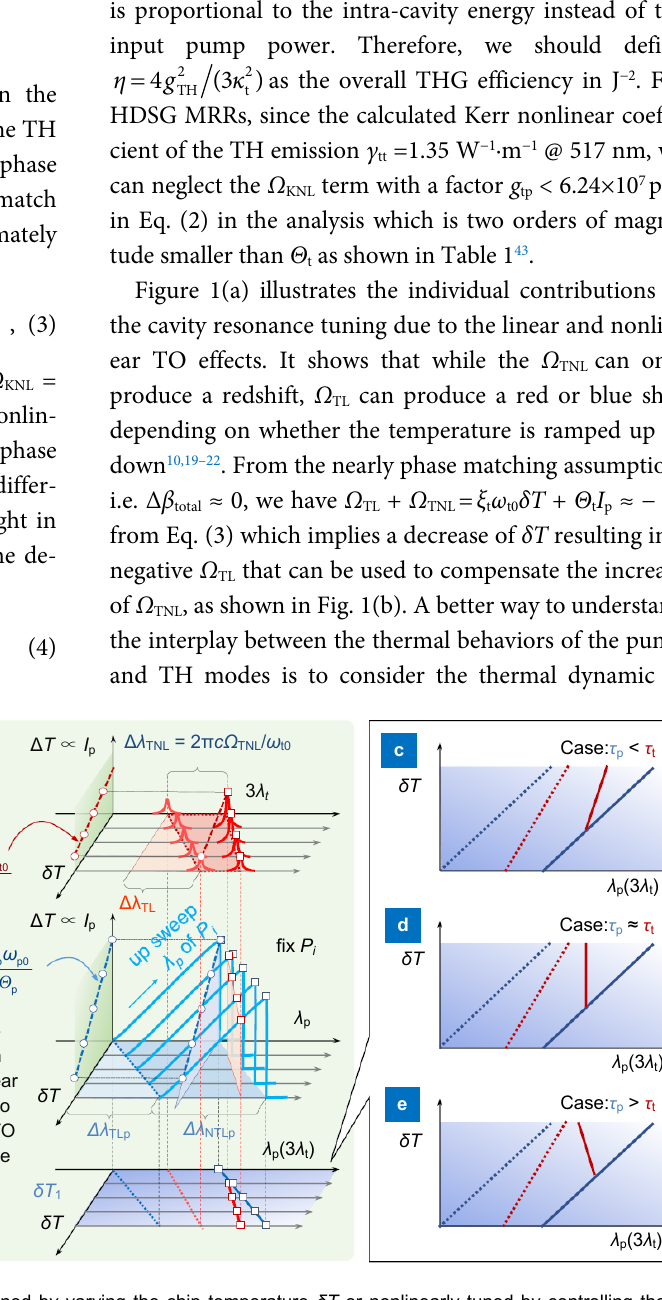
Fig. 1 | ( a ) The cavity resonance of MRRs can be linearly tuned by varying the chip temperature δ T or nonlinearly tuned by controlling the in- tra-cavity pump energy I p through nonlinear TO effects. ( b ) In the wavelength domain, when δ T increases, the cold-cavity resonance wavelengths of the TH mode (in red dot line) and the pump mode (in blue dot line) will linearly redshift ∆ λ TL and ∆ λ TLp , respectively. When up sweeping the CW input pump wavelength λ p and δ T are fixed, the corresponding I p will induce nonlinear redshift ∆ λ TNL and ∆ λ TNLp to the resonance wavelengths of the TH and pump modes, respectively. For the pump mode, when λ p is fixed, the trace of blue open circles determines τ p which is the ratio between δ T and I p . Similarly, the trace of red open circles in the upper part of (b) gives the ratio τ p . The overall effects of ∆ λ TL and ∆ λ TNL determine the effective TDWS of the TH mode which becomes a δ T- λ p relationship by mapping the trace of red open squares to the lower part of (b). For the pump mode, its TDWS is only related the linear TO redshift ∆ λ TLp whose trace was shown as blue open squares plotted in the δ T- λ p diagram. ( c – e ) The thermal mismatch between τ p and τ t will determine the effective TDWS of the TH mode, which leads to (c) a positive TDWS when τ p < τ t and (d) a zero TDWS when τ p ≈ τ t and (e) a negative TDWS when τ p > τ t in the δ T- λ p